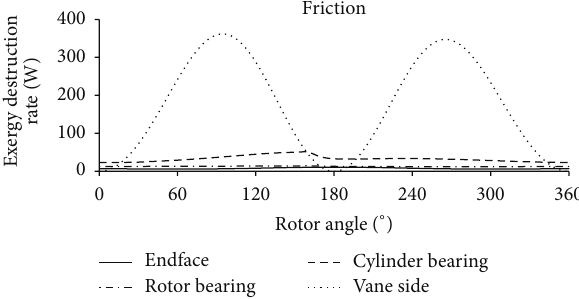
Figure 4: Exergy destruction rate due to